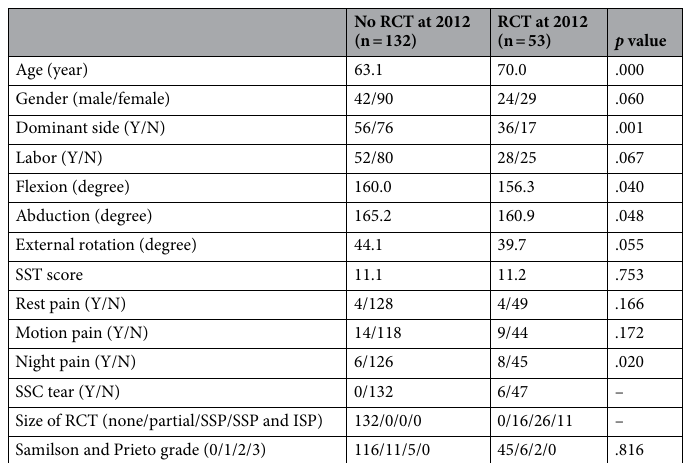
Table 1. Comparison of parameters between shoulders without RCT and shoulders with RCT in 2012.